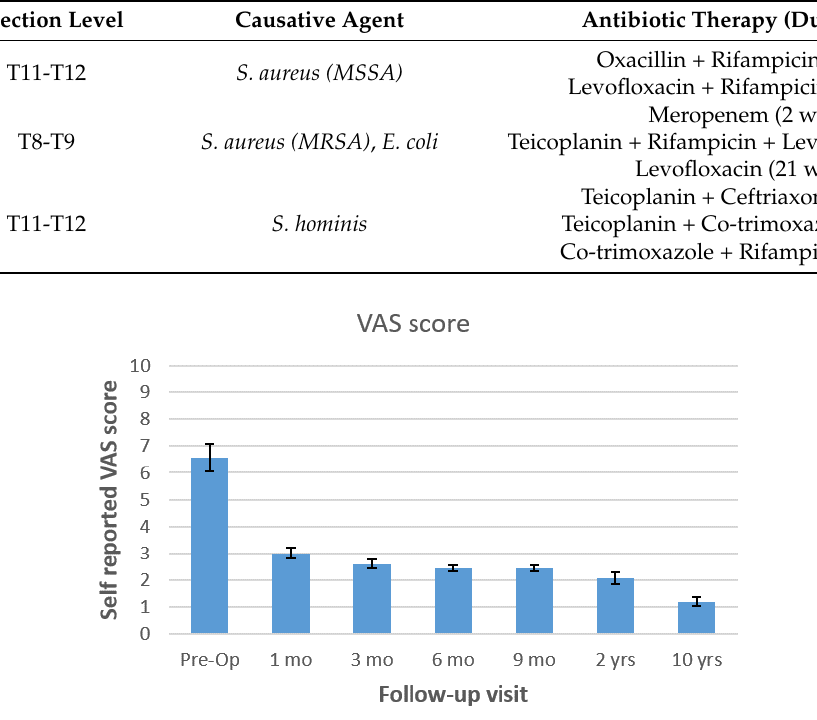
Table 2. Spinal level, causative agent, antibiotic therapy.